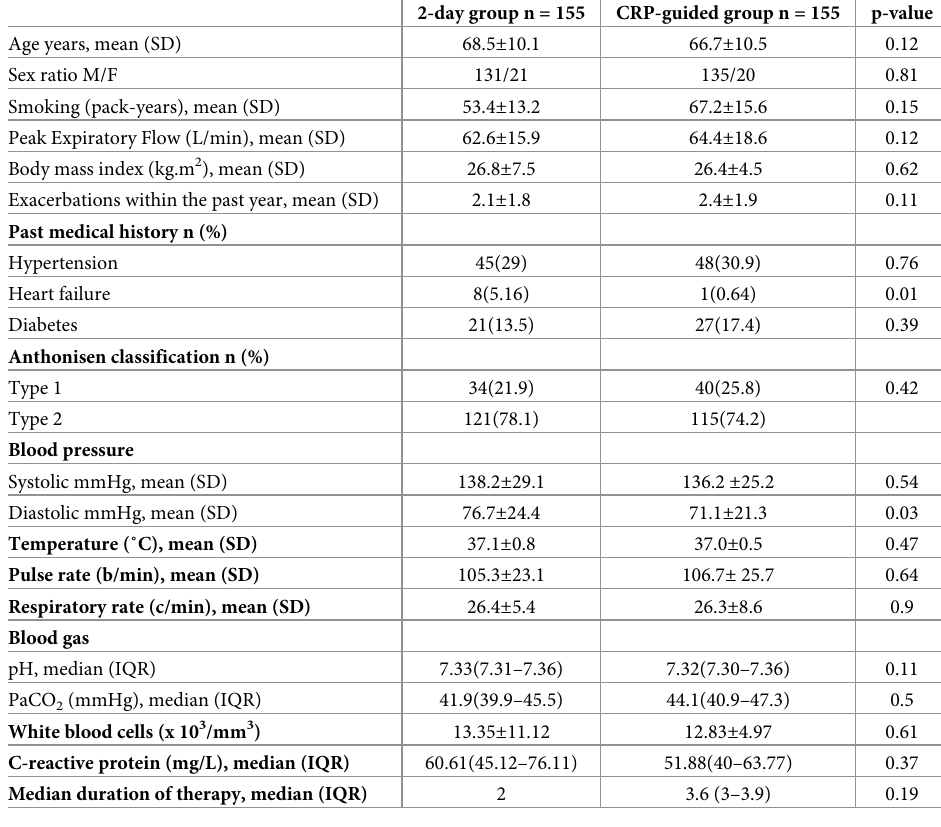
Table 1. Patients’ demographic and clinical characteristics at admission � .